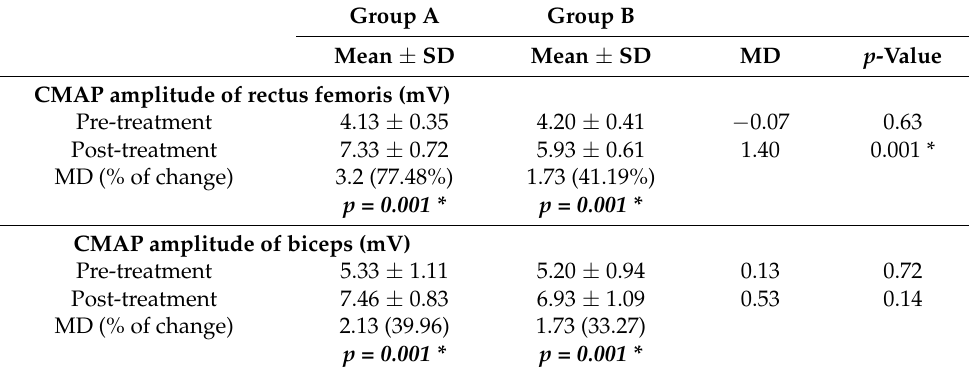
Table 3. CMAP amplitude, isometric muscle force, PedsQL TM MFS, PedsQL, and 6MWD of both